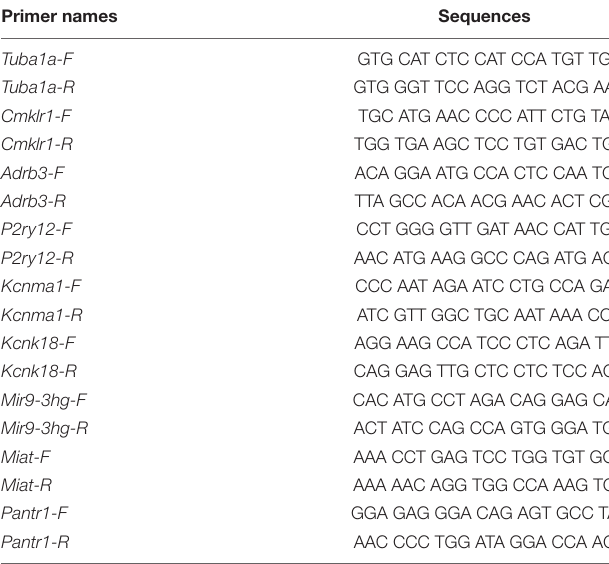
TABLE 1 | Primers for